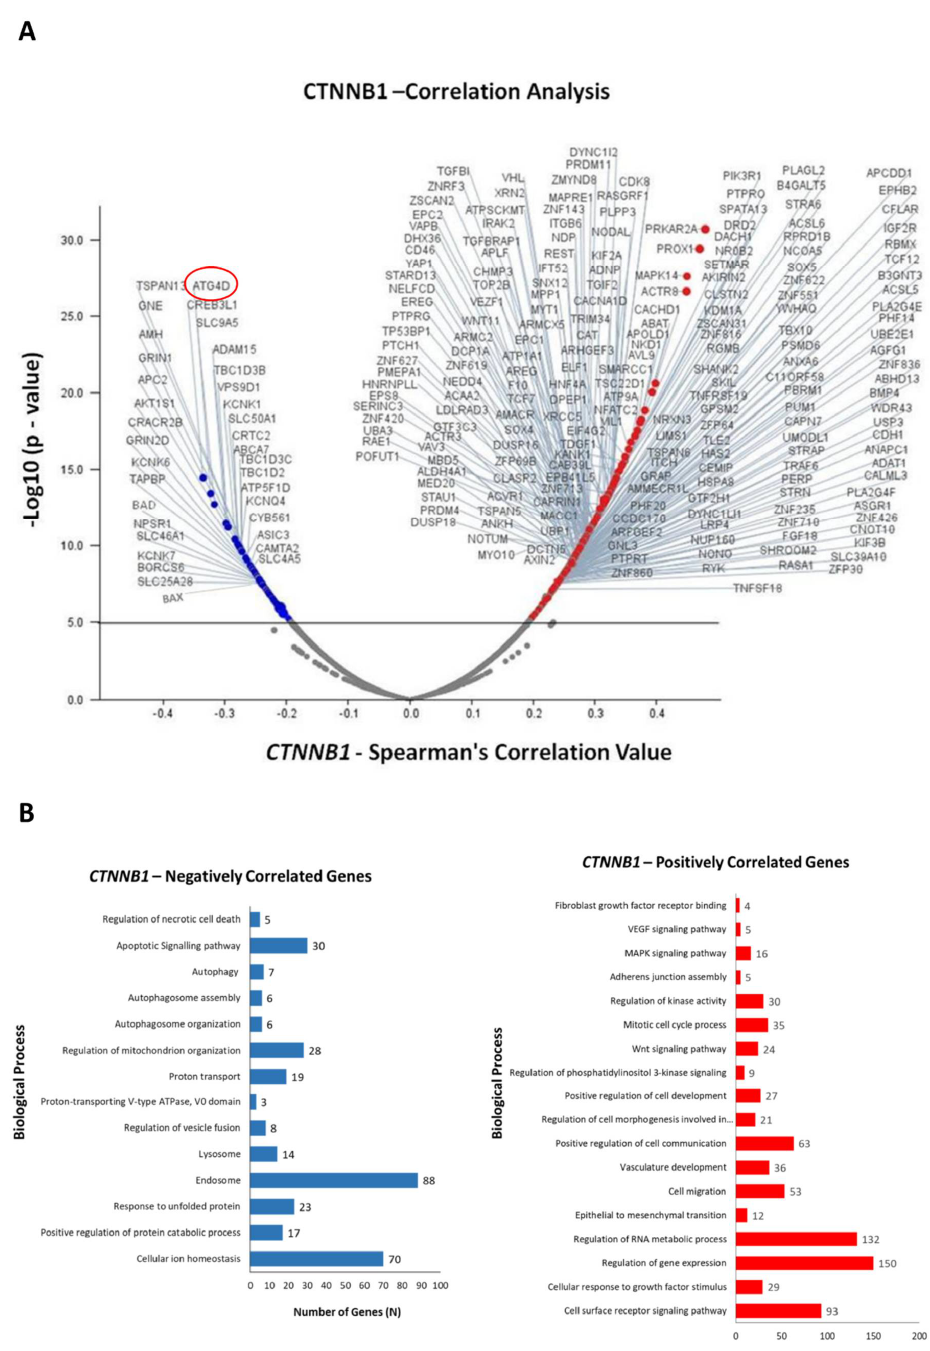
Figure 4. Differential modulation of biological processes by CTNNB1 ( β -Catenin) in colorectal adenocarcinoma patients. ( A ) Volcano plot displaying the differentially expressed genes (DEGs). Red dots represent CTNNB1 -positively correlated genes (logFC/correlation value: +0.25), while blue dots represent CTNNB1 -negatively correlated genes (logFC/correlation value: − 0.25). ( B ) The bar graphs report the biological processes negatively (blue) and positively (red) correlated with CTNNB1